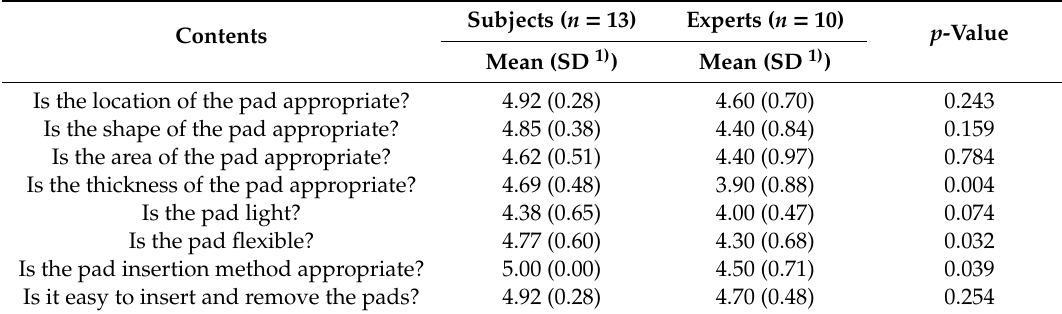
Table 8. Results of the evaluation of pad characteristics.